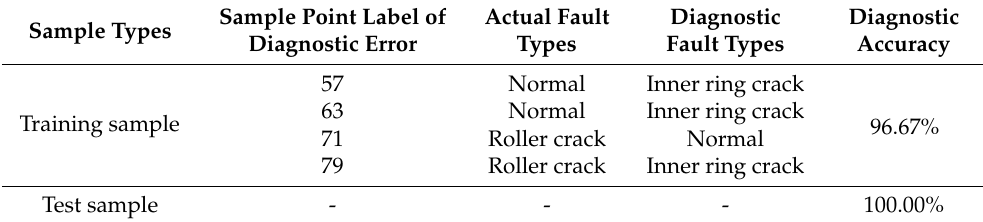
Table 7. Diagnostic error types of different